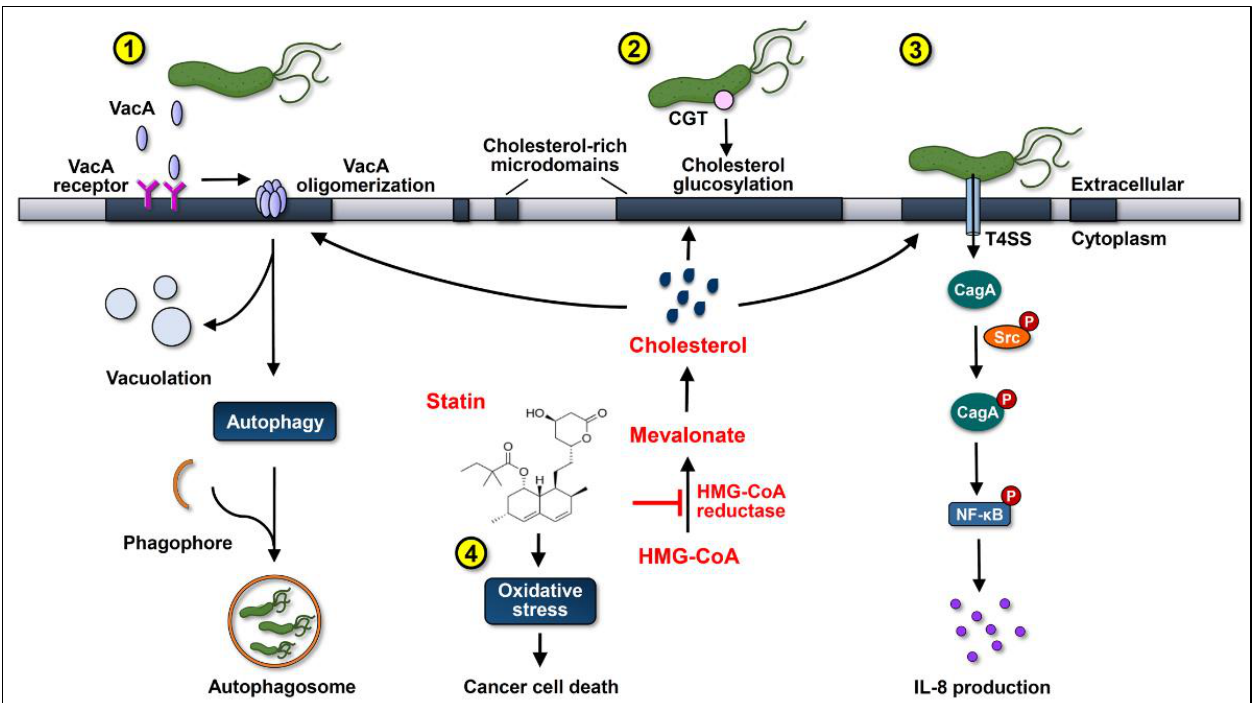
Figure 1. Statins inhibit cholesterol synthesis by interrupting the conversion of 3-hydroxy-3-methylglutaryl-coenzyme A (HMG-CoA) to mevalonate, consequently suppressing the actions of the virulence factors of Helicobacter pylori and increasing oxidative stress to promote gastric cancer cell death. (1) After cholesterol-dependent internalization, vacuolating cytotoxin A (VacA) induces vacuolation in the late endosomal compartments in host cells. Subsequently, VacA promotes autophagy and interferes with lysosomal functions, which sequesters H. pylori in intracellular niches to multiply. (2) Cholesterol-α-glucosyltransferase (CGT) catalyzes the glucosylation of cholesterol, contributing to immune evasion and intracellular survival of H. pylori . (3) Cytotoxin-associated gene A (CagA) translocation/phosphorylation depends on the coalescence of cholesterol-rich microdomains and glucosylated cholesterol, which in turn activates the nuclear factor-kappa B (NF-κB) and enhances the production of interleukin (IL)-8. The use of statins reduces the cellular cholesterol levels, inhibits the internalization of VacA, decreases the glucosylation of cholesterol, and attenuates the actions of CagA, thereby alleviating the H. pylori -induced pathogenesis. (4) Statins increase the production of reactive oxygen species (ROS) to enhance oxidative stress, thereby synergistically promoting their anti-cancer properties.